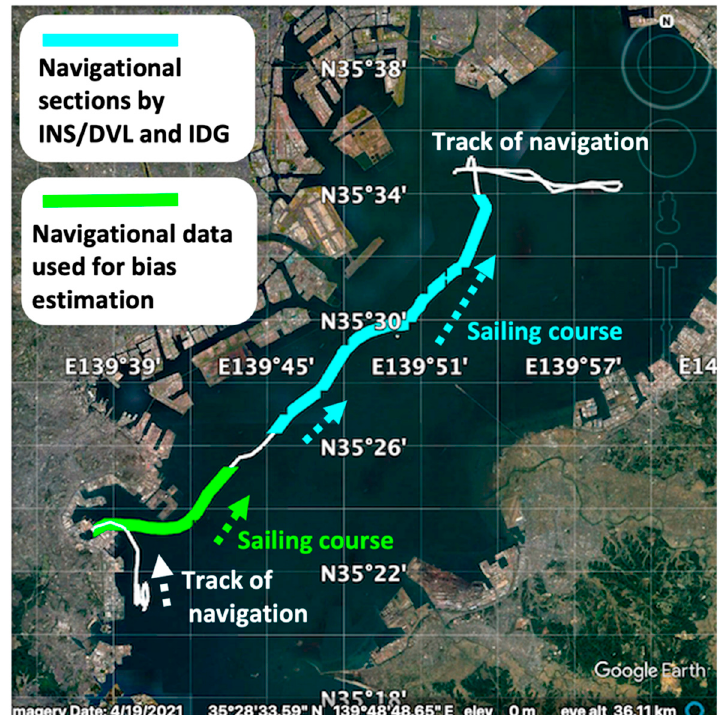
Figure 3. Navigation track of the experiment. Table 2. Sensor information.